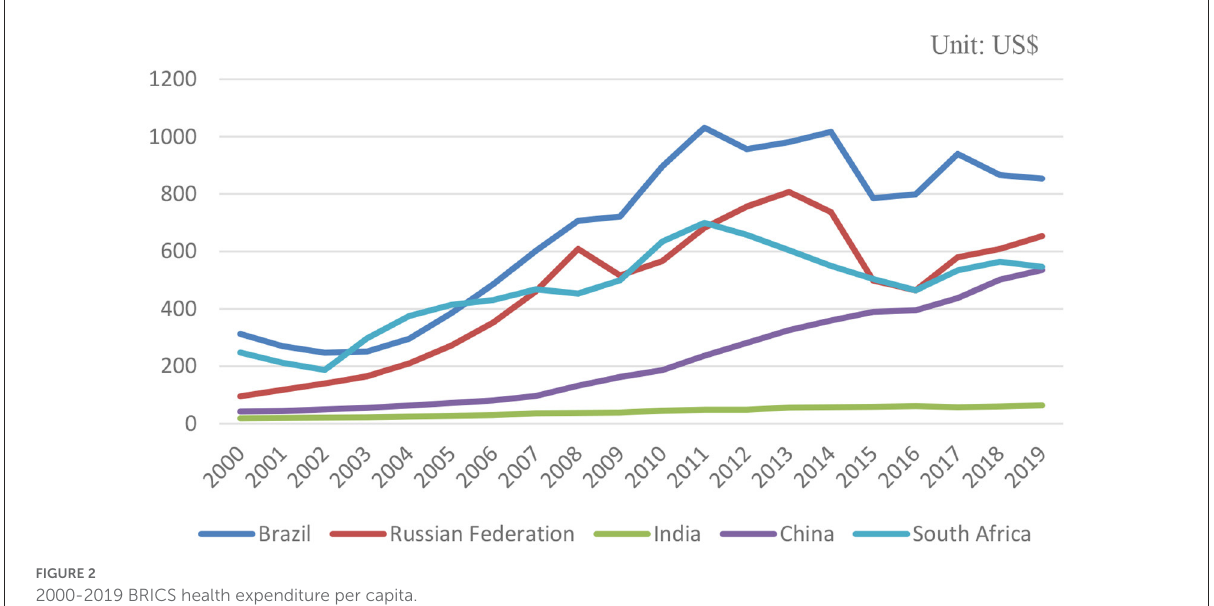
FIGURE2 2000-2019 BRICS health expenditure per